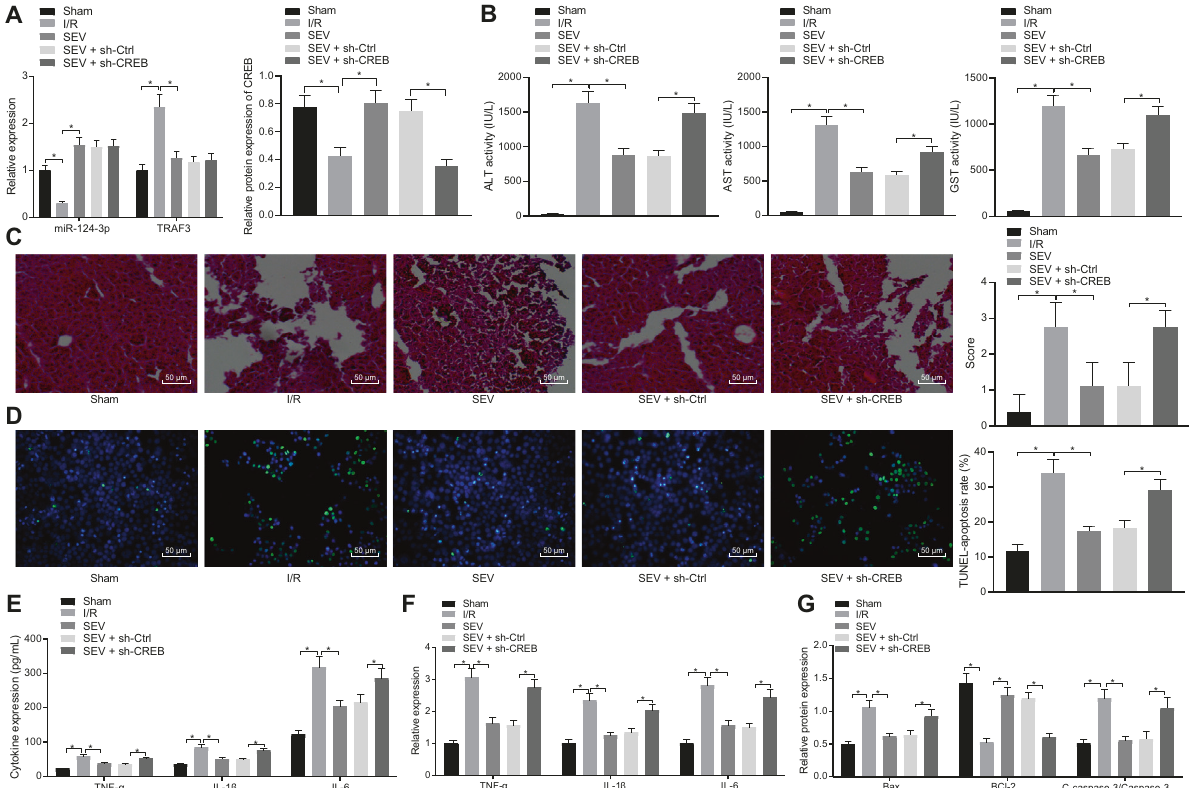
Fig. 6 SEV inhibits hepatic I/R injury in mice through the miR-124-3p/TRAF3/CREB axis. A The expression of miR-124-3p and TRAF3 mRNA determined by RT-qPCR and CREB protein expression measured by Western blot analysis in liver tissues of sham-operated mice, I/R mice or I/R mice treated with SEV/SEV + sh-CREB. B Serum levels of GST, ALT, and AST in sham-operated mice, I/R mice or I/R mice treated with SEV/SEV + sh-CREB detected by ELISA. C Liver tissue injury in sham-operated mice, I/R mice or I/R mice treated with SEV/SEV + sh-CREB determined by HE staining (200×). D Hepatocyte apoptosis in sham-operated mice, I/R mice or I/R mice treated with SEV/SEV + sh-CREB detected by TUNEL staining (200×). E The expression of serum TNF- α , IL-1 β , and IL-6 in sham-operated mice, I/R mice or I/R mice treated with SEV/SEV + sh-CREB detected by ELISA. F The expression of TNF- α , IL-1 β , and IL-6 in liver tissues of sham-operated mice, I/R mice or I/R mice treated with SEV/SEV + sh-CREB detected by RT-qPCR. G The protein expression of Bax, Bcl-2, and cleaved-caspase-3 in liver tissues of sham-operated mice, I/R mice or I/R mice treated with SEV/SEV + sh-CREB detected by Western blot analysis. * p < 0.05, n =